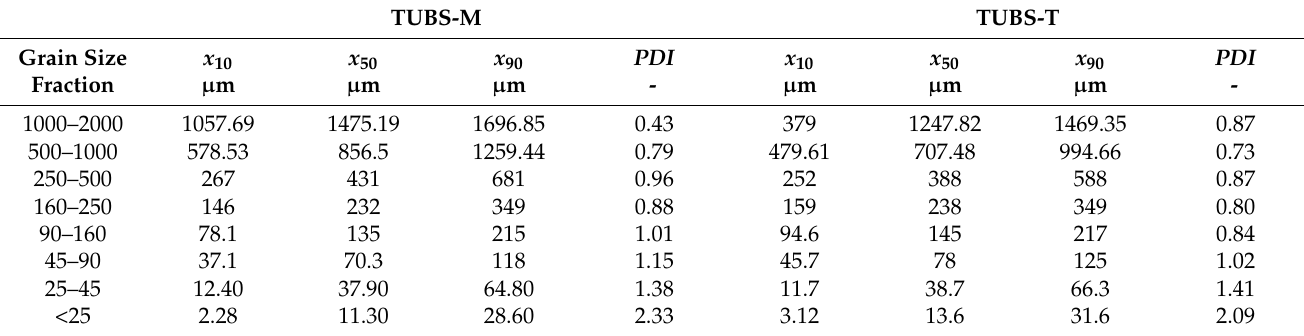
Table 1. Particle sizes of the grain size fractions of both regolith simulants.